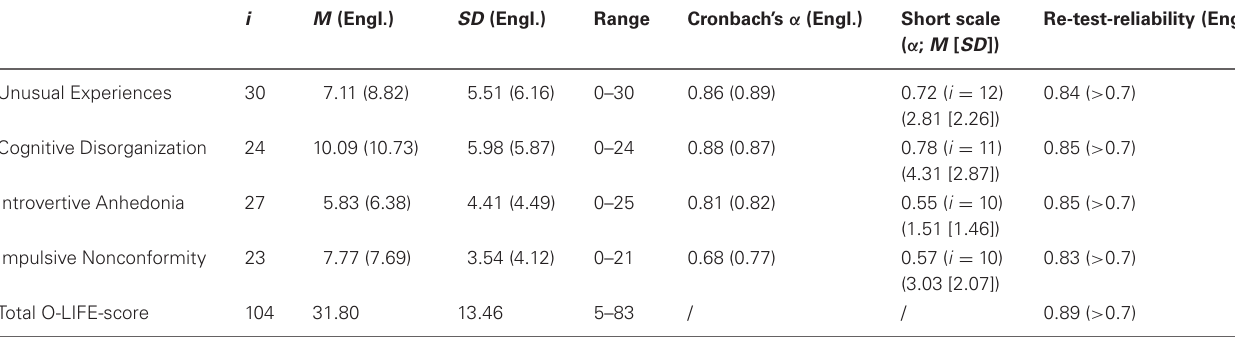
Table 1 | Statistical properties of the German O-LIFE and comparison to the